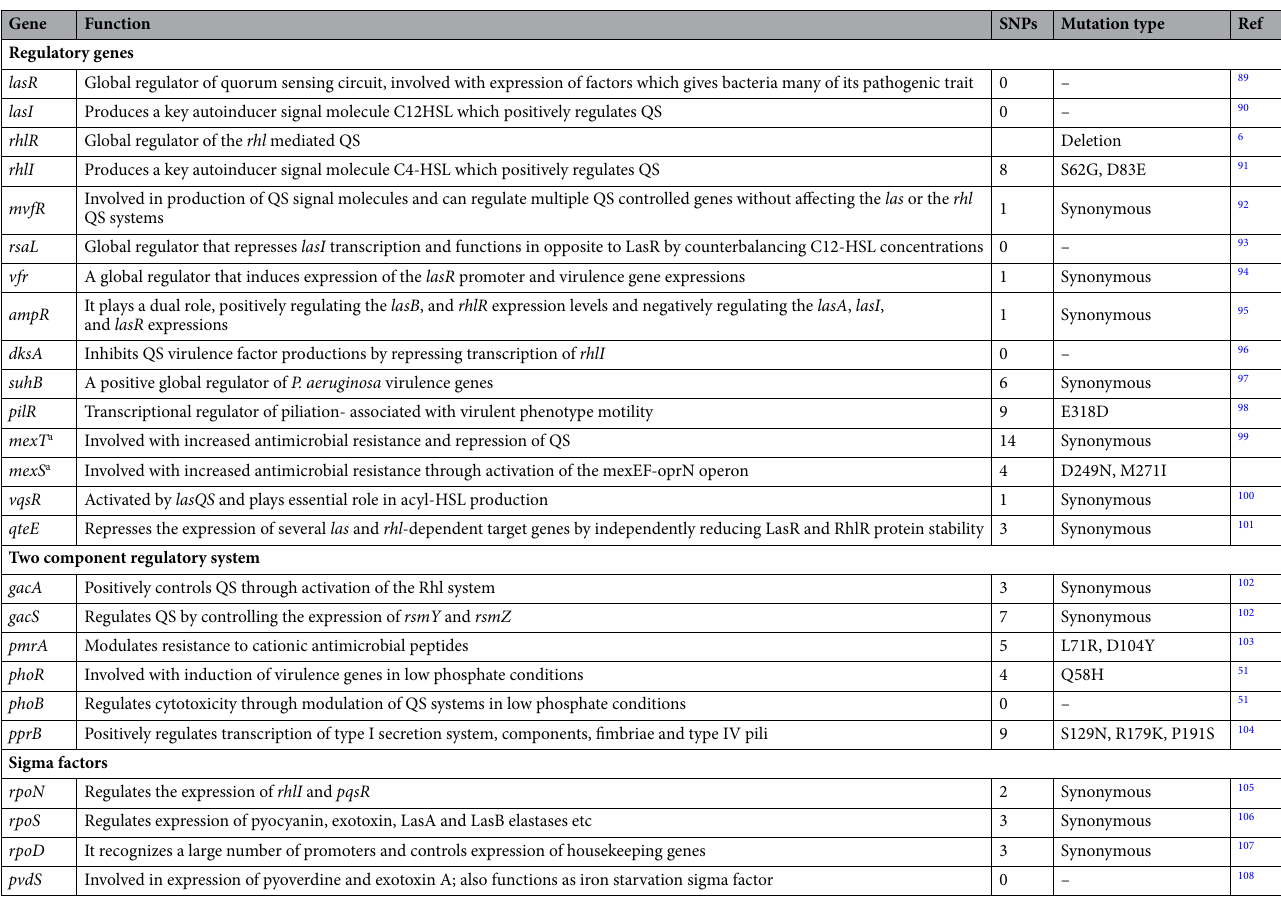
Table 1. PA80 genetic variations relative to PAO1. a PA80 MexT and MexS sequences were aligned with